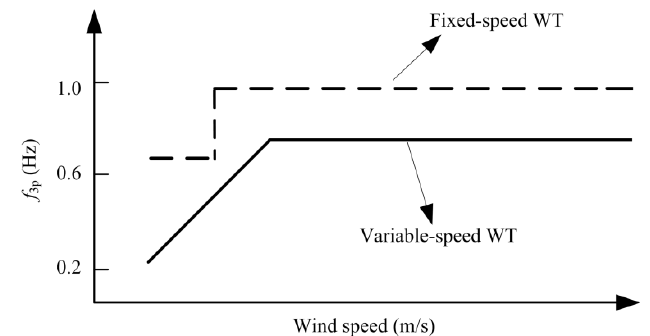
Figure 1. 3p Frequency with two types of wind